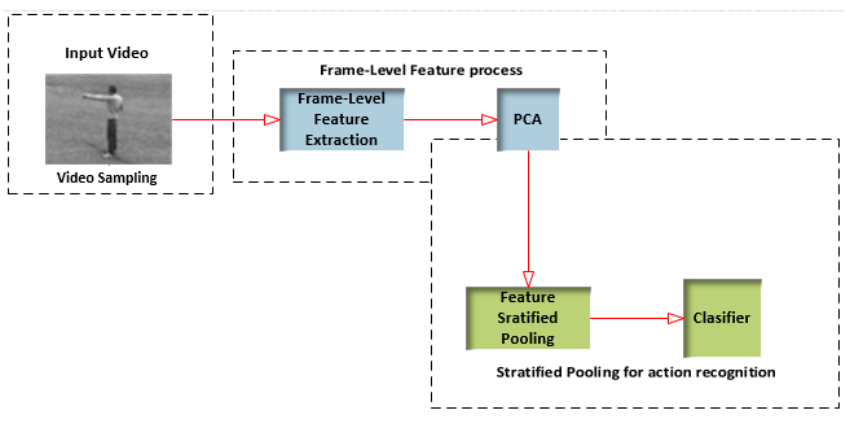
Figure 10. An example of stratified pooling with CNN .